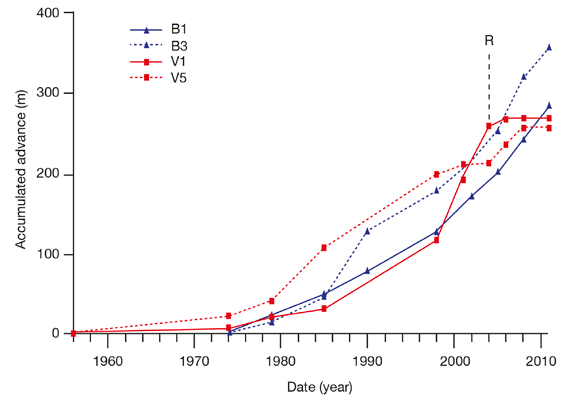
Fig. 11. – Accumulated dune advance for Bolonia profiles (B1 and B3) and Valdevaqueros profiles (V1 and V5) during the study pe- riod (1956-2011). R, Point at which profile V1 reached the